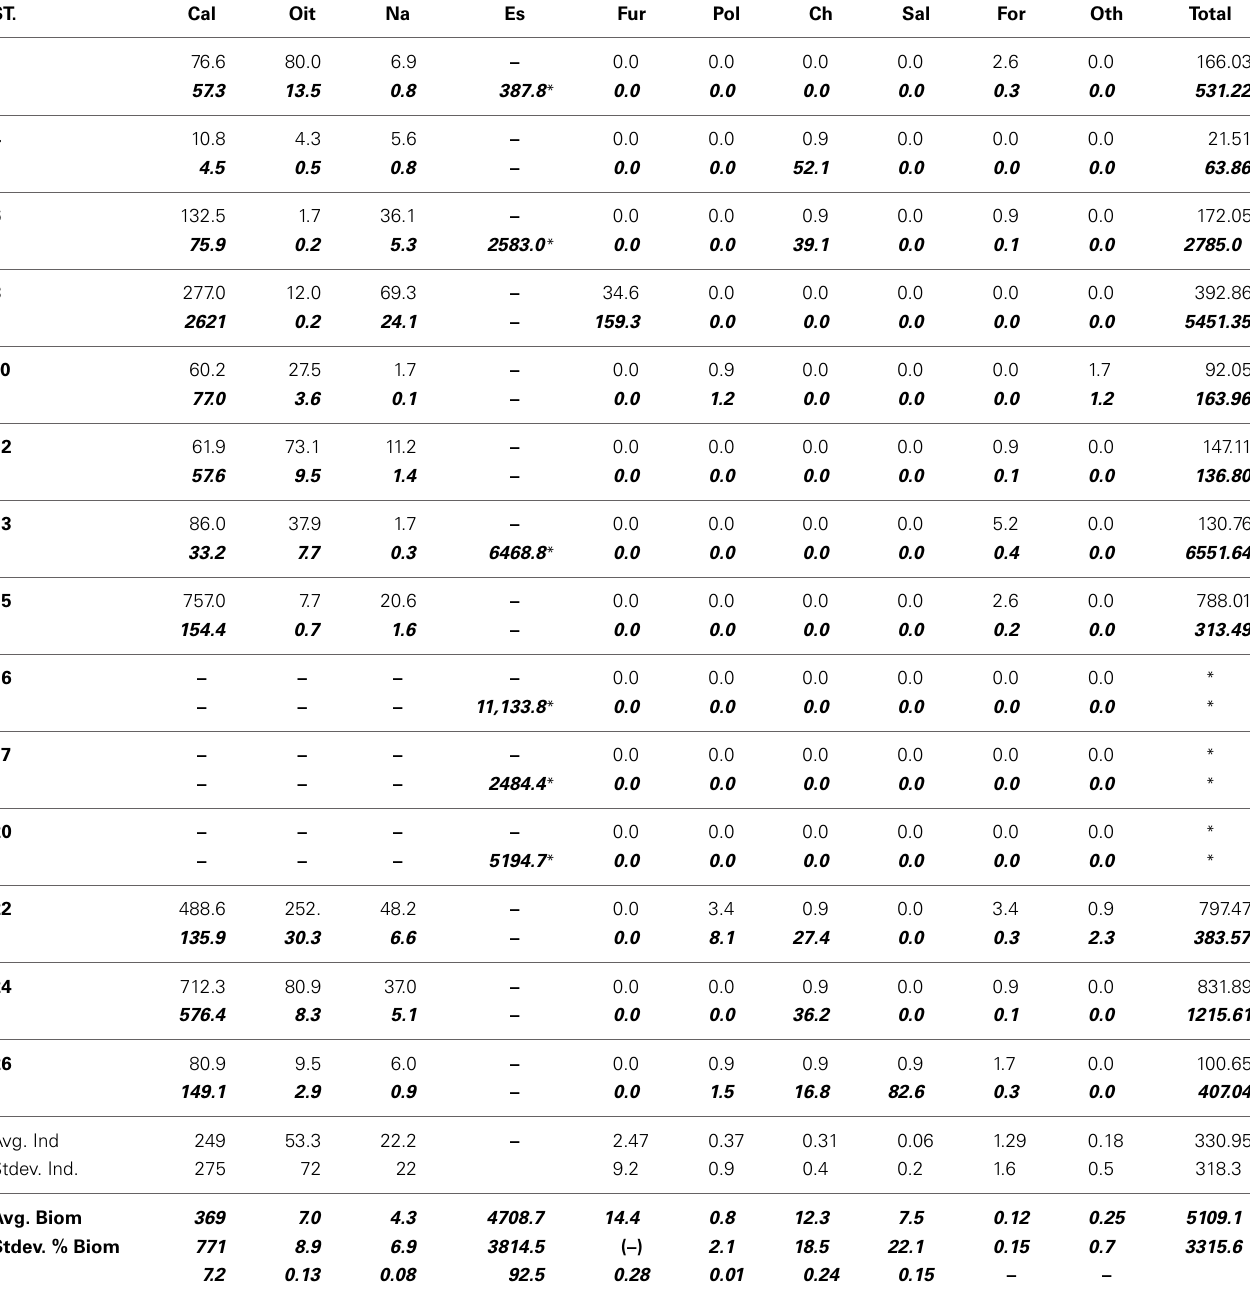
Table 1 | Taxonomic composition (ind m − 3 ) and biomass ( µ mol C m − 3 , bold italics) for the main zooplankton groups in the studied stations (see